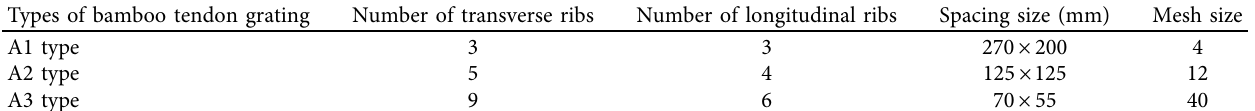
Table 2: Different arrangements of bamboo tendon grating.